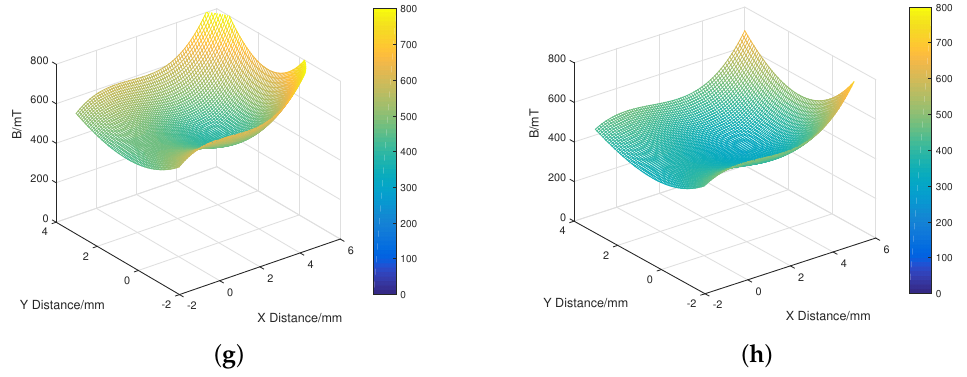
Figure 4. Magnetic flux density distribution of four air gaps under I = 0 and 10 mA. ( a ) Magnetic flux density of air gap 1 ( I = 0 mA). ( b ) Magnetic flux density of air gap 1 ( I = 10 mA). ( c ) Magnetic flux density of air gap 2 ( I = 0 mA). ( d ) Magnetic flux density of air gap 2 ( I = 10 mA). ( e ) Magnetic flux density of air gap 3 ( I = 0 mA). ( f ) Magnetic flux density of air gap 3 ( I = 10 mA). ( g ) Magnetic flux density of air gap 4 ( I = 0 mA). ( h ) Magnetic flux density of air gap 4 ( I = 10